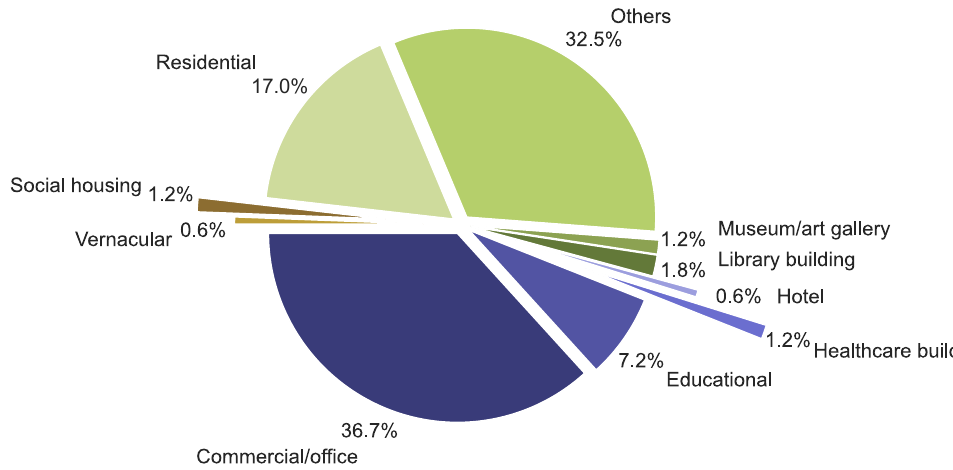
Figure 18. Type of buildings considered in the